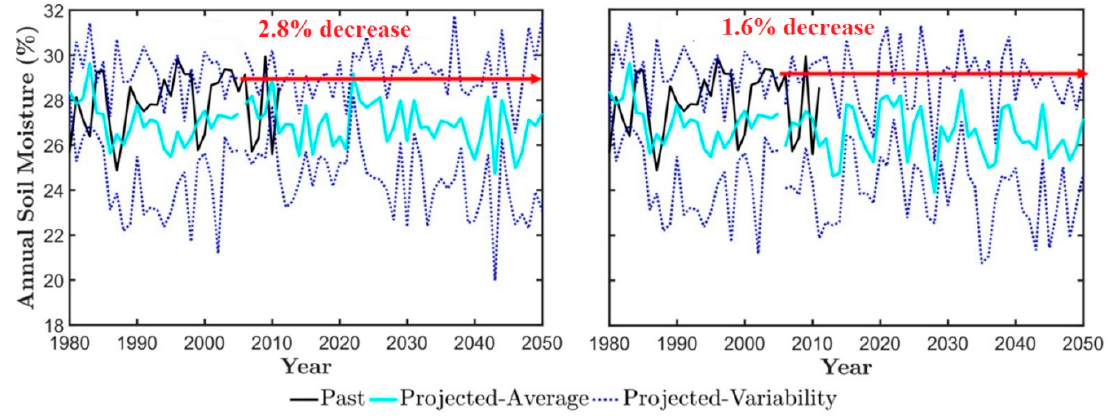
Figure 12. Time series of annual soil moisture based on four GCM models for the historical period (1980–2005) and projected period (2006–2050) considering RCP 4.5 ( left ) and RCP 8.5 ( right ). The average curve is the average of four GCM models, and the variability curves are the minimum and maximum of four models. The red line is the slope of the time series during the projected period. The percent change from 2006 to 2050 is shown in red above each line.